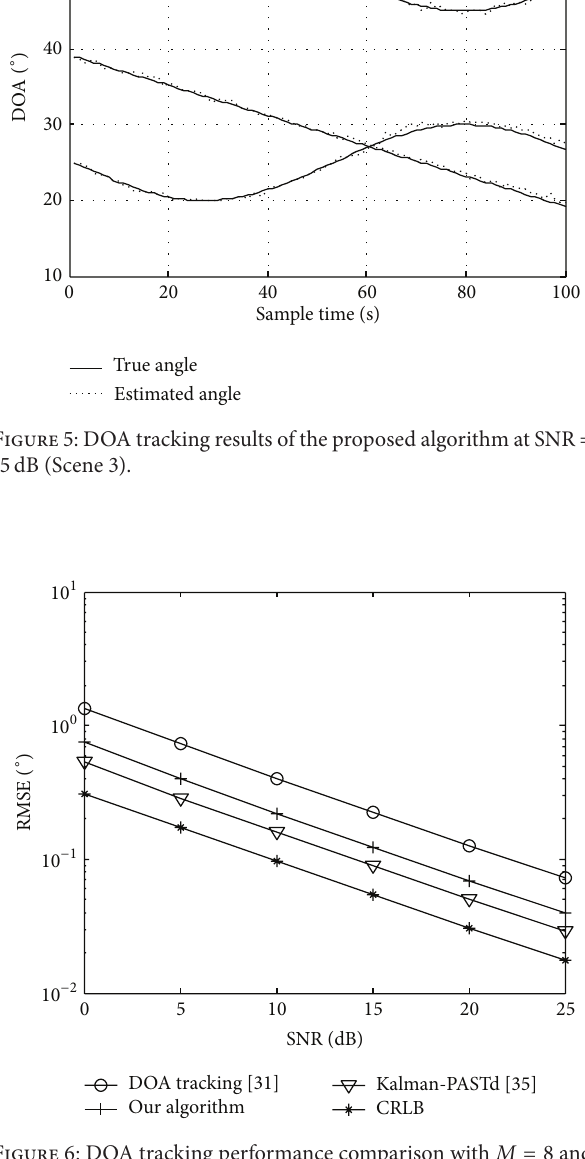
Figure 6: DOA tracking performance comparison with 𝑀 = 8 and 𝑁 = 6 .